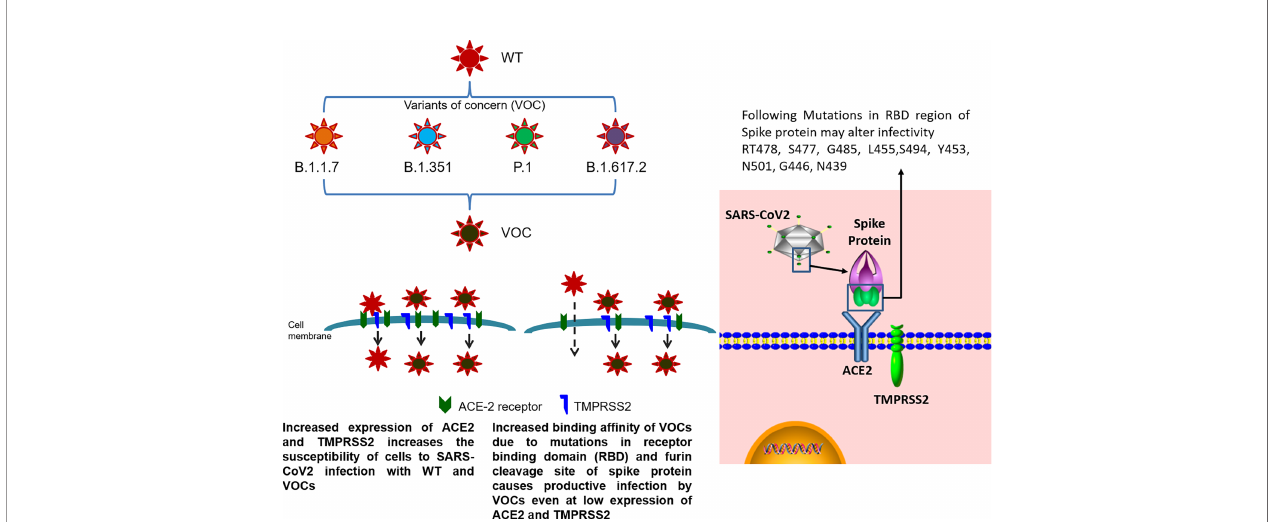
FIGURE 2 | Infective potential of wild-type SARS-CoV2 and its VOC. SARS-CoV2 infection occurs by the receptor-mediated entry of the virus into the host cells using ACE2 receptor in the presence of TMPRSS2 protease. Higher expression of ACE2 receptor and TMPRSS2 on the cell membrane of host cells causes internalization of both wild-type SARS-CoV2 and its VOC. In cells with low levels of ACE2 and TMPRSS2 expression, the mutations present in the receptor binding domain (RBD) of the spike protein (RT478, S477, G485, L455, S494, Y453, N501, G446, and N439) of VOC allows for ef fi cient binding of the variant to the host receptors even at low expression levels as compared to the wild-type virus, contributing towards the enhanced transmissibility of